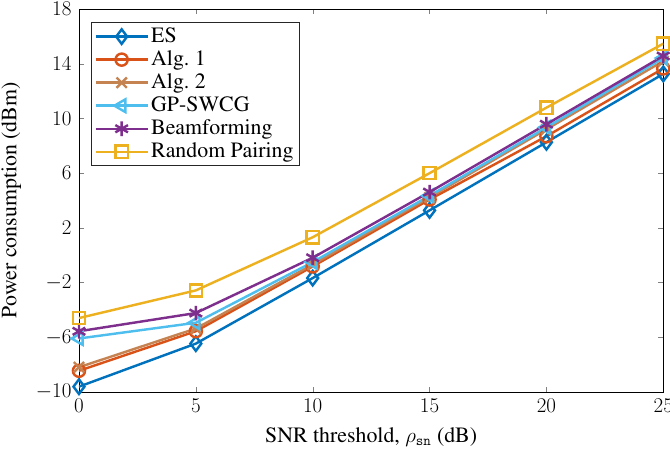
Figure 6. Power consumption versus received SNR threshold.